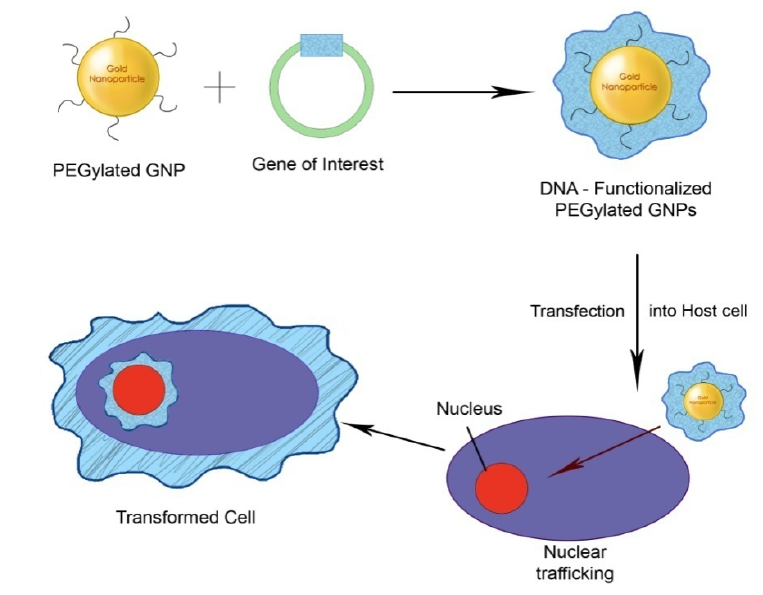
Figure 2. PEGylated gold nanoparticles (GNPs) for gene